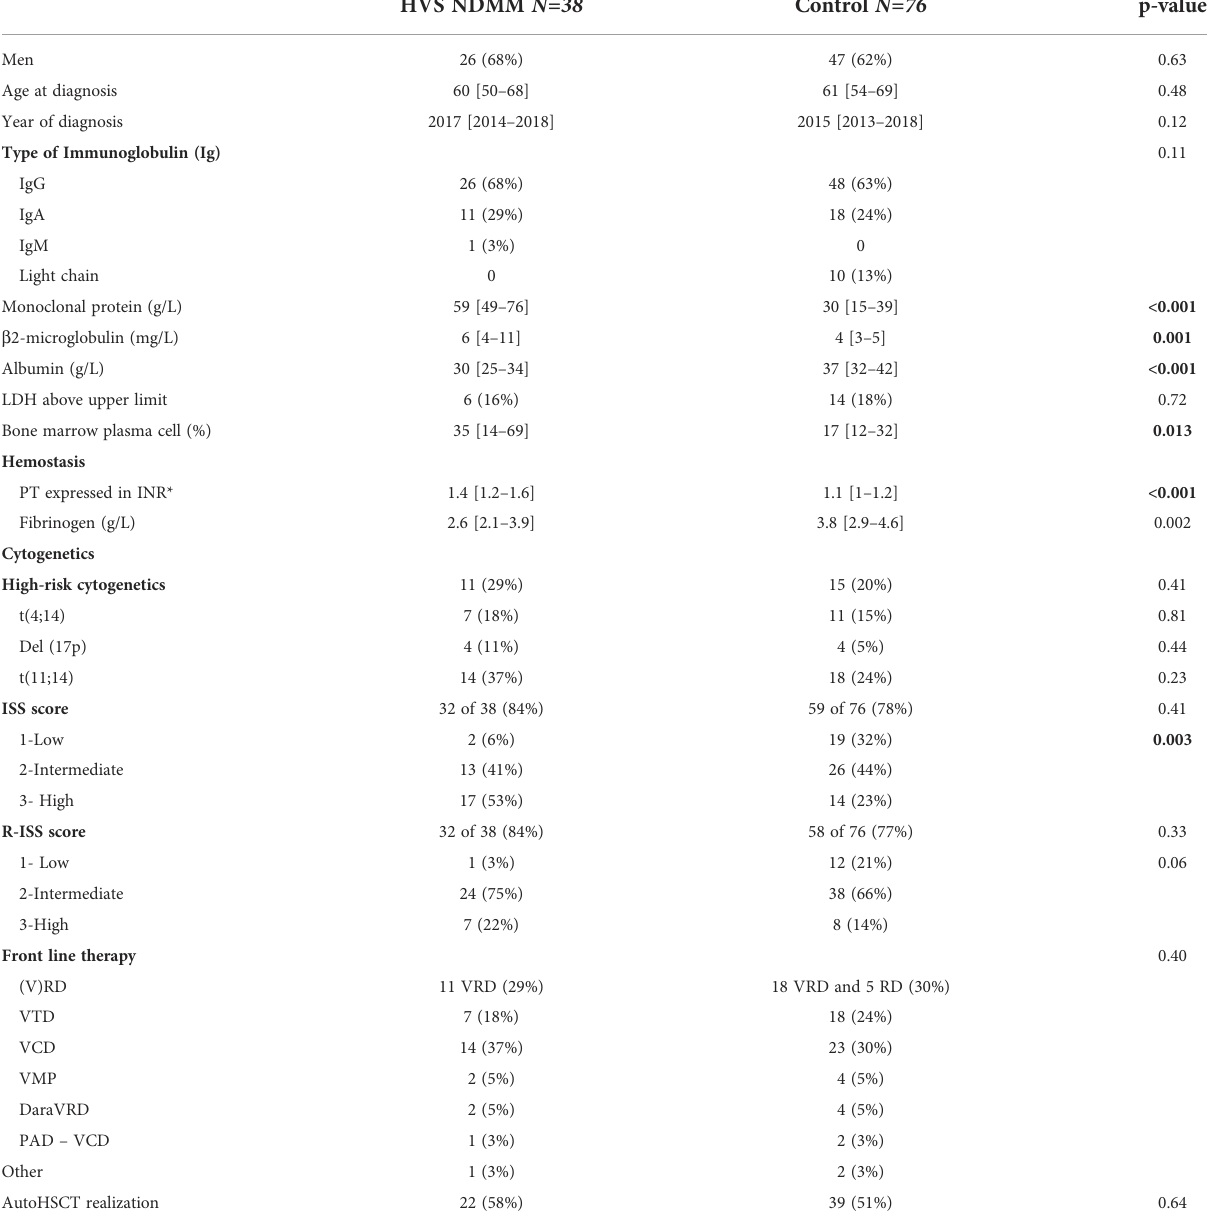
Continuousvariablesarepresentedwith%.NumericalvariablesarepresentedwithmedianandIQR.AutoHSCT,autologoushematopoieticstemcelltransplantation;ISS,internationalscoresystem;PT, prothrombin time; INR, international normalized ratio; *normal INR, < 1.25; R-ISS, revised ISS; VCD, bortezomib + cyclophosphamide + dexamethasone; VRD, bortezomib + lenalidomide +